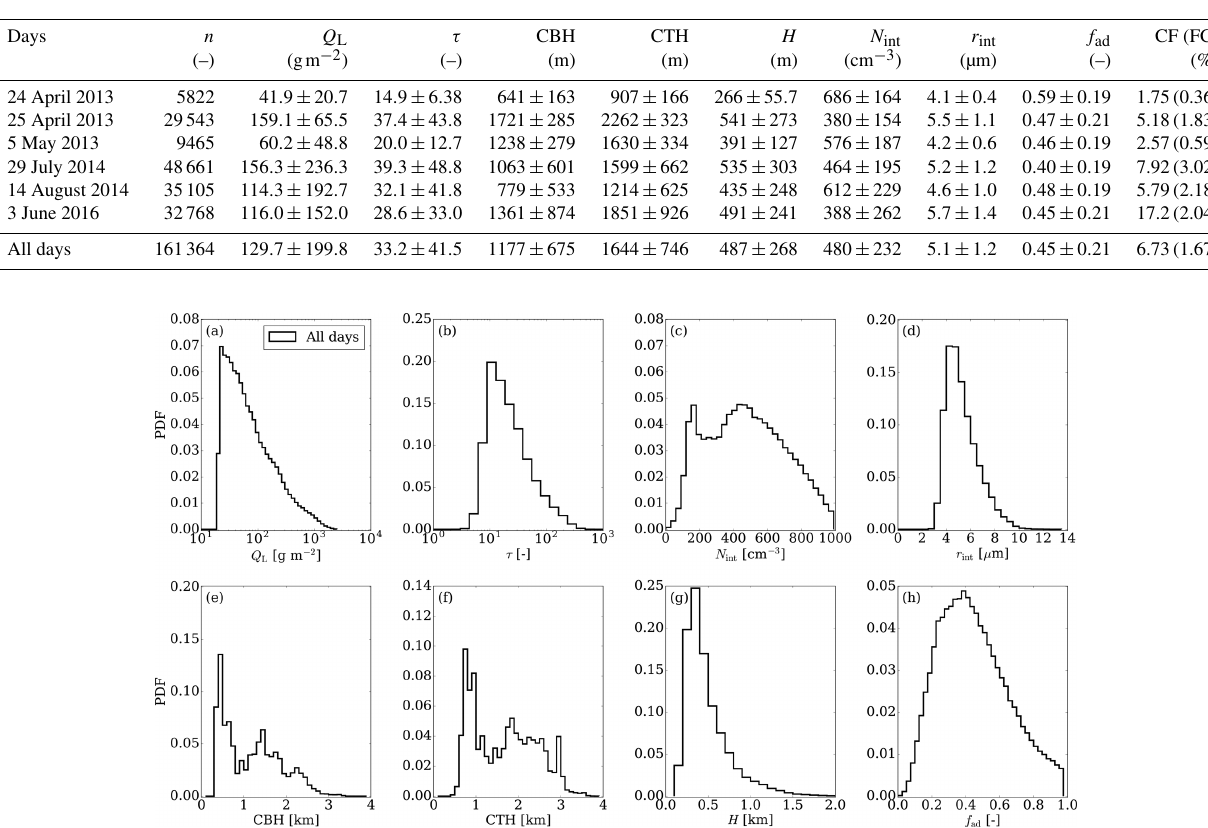
Table 1. Statistics of cloud properties of low-level clouds for all the case days individually and on average as simulated by ICON-LEM. n stands for the sample size. For the fraction of clouds, two values are presented: values in brackets denote the fraction of selected clouds (FC) according to the column selection (see Sect. 2.4), while values outside brackets stand for the actual cloud fraction (CF) in terms of the following threshold for the liquid water path, Q L > 1gm − 2 .